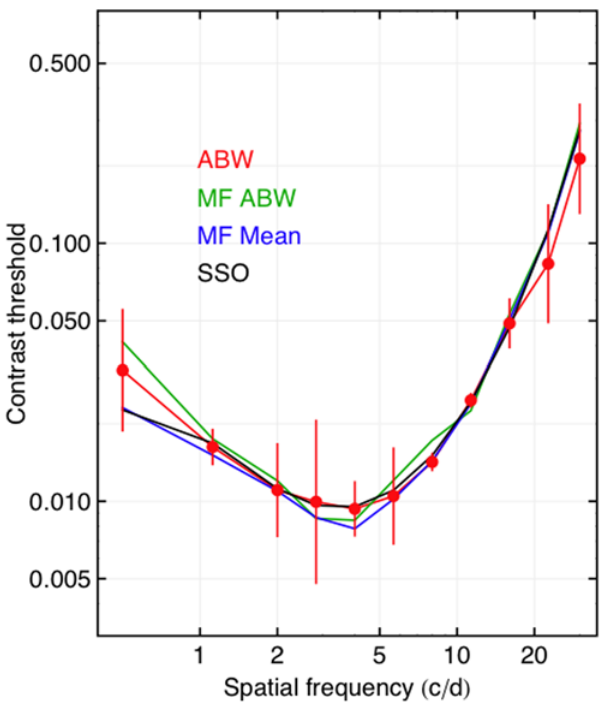
Figure 6. Contrast thresholds for Gabor stimuli for observer ABW from the present experiment (red), along with ABW data from the original ModelFest experiment (green), the mean data from the ModelFest experiment (blue), and the predic- tions of the Spatial Standard Observer (black). The error bars are plus and minus one standard deviation. The lowest frequency point is for 0 cycles/deg (a simple Gaussian, see Figure 2).